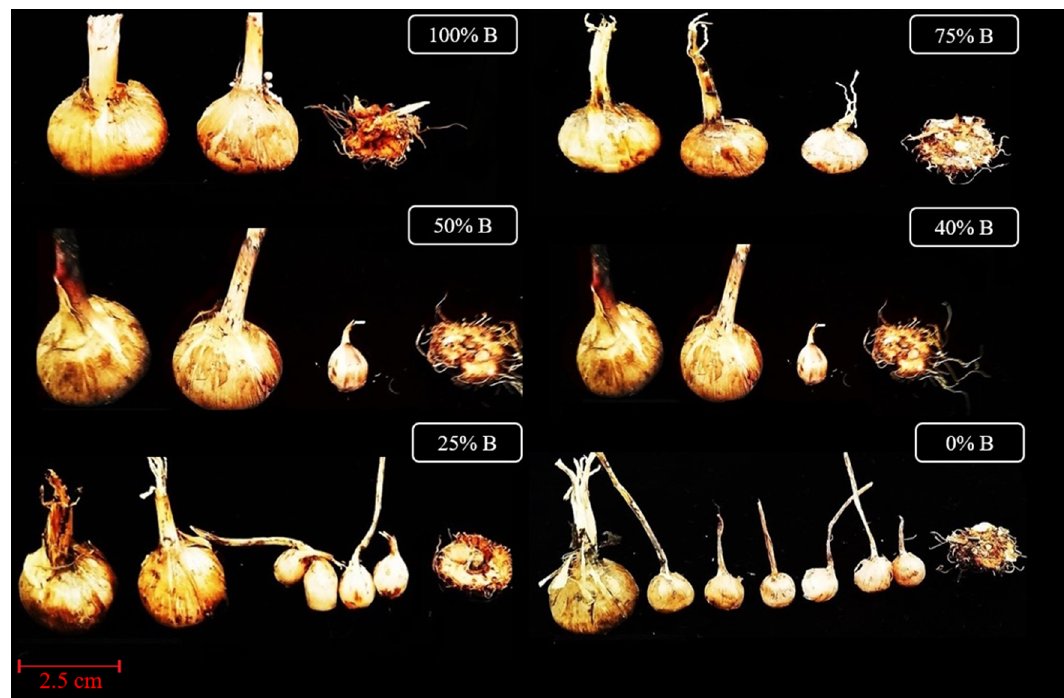
Figure 2. Saffron corms produced under different ratios of Blue (B) light in the overall spectral composition, including 100% B, 75% B, 50% B, 40% B, 25% B, 0% B (see the spectrum in Figure 1), with 150 ± 10 μ mol m − 2 s − 1 PPFD. In each treatment, the new corms are arranged based on their weight from largest to smallest together with the last one, which is the remains remainingof the mother corm.